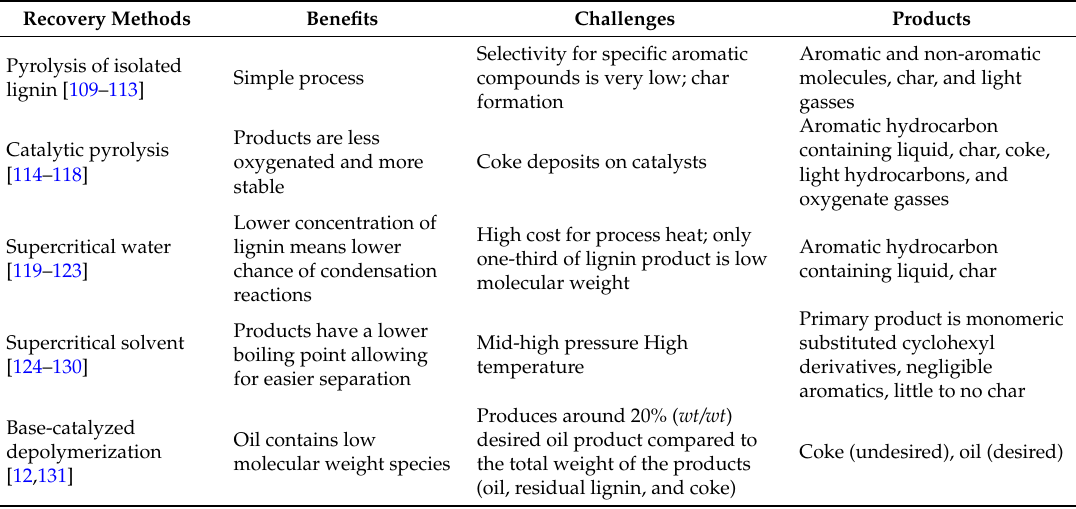
Table 4. Non-biological depolymerization methods for isolated